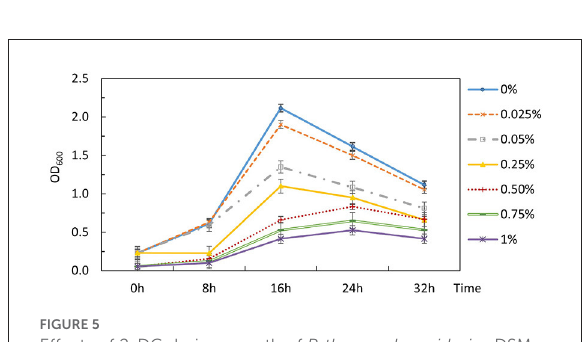
FIGURE5 Effects of 2-DG during growth of P. thermoglucosidasius DSM 2542 on xylose in 50 mL conical centrifuge tubes. P. thermoglucosidasius DSM 2542 was grown in ASM medium supplemented with 1% (w/v) xylose and different concentrations of 2-DG (% w/v shown on the right). Error bars are ± standard deviation of three technical repeats.